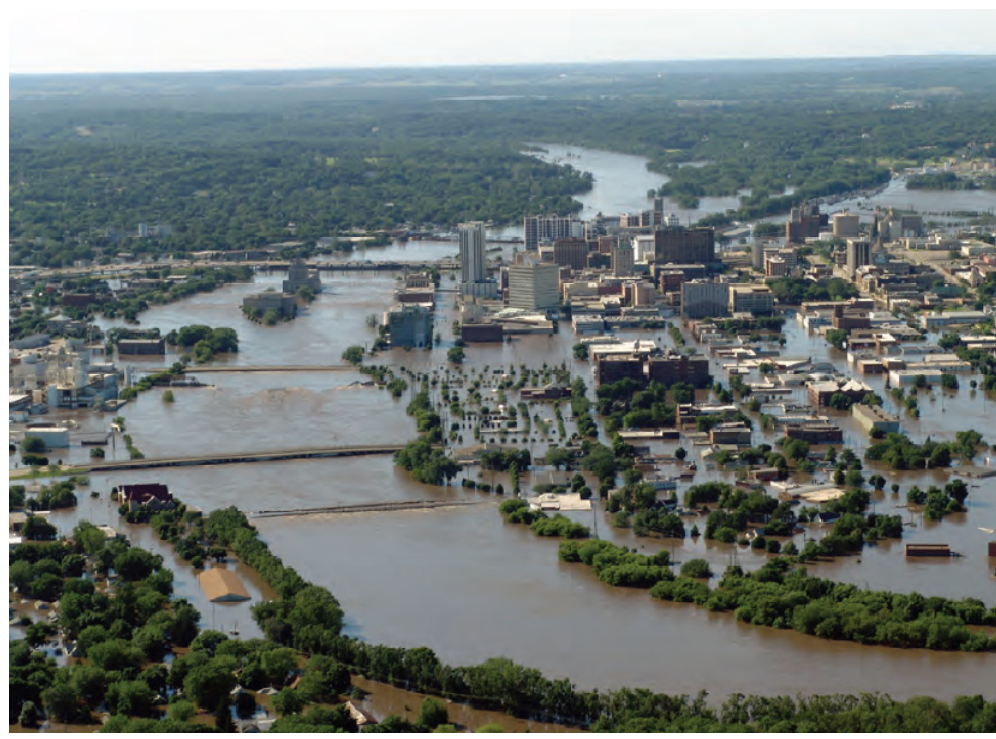
Figure 4. Downtown Cedar Rapids, Iowa at the peak of the 2008 flood, taken from Buchmiller